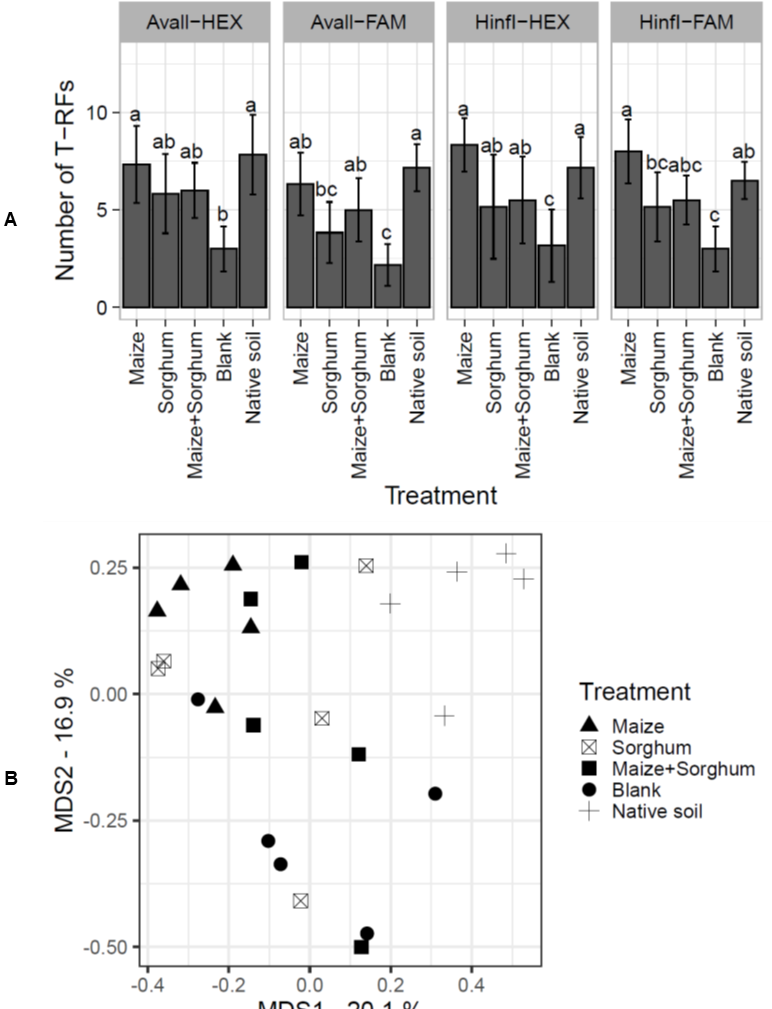
Figure 6. AMF community in trap cultures. 800-bp SSU regions of AMF from various trap cultures, including maize, sorghum, maize + sorghum, blank and native soil, were amplified by the HEX- labelled AML1 primer and FAM-labelled AML2 primer. The terminal restriction fragments (TRFs) in each sample ( n = 6 biological replicates) were derived from the digestion of PCR products by AvaII and HinfI ( A ). Statistical analysis was performed by one-way ANOVA following LSD. Different letters indicate significant differences ( p < 0.05). The multidimensional scaling plot of AMF community compositions ( n = 5 – 6 biological replicates) found in the trap culture soils was generated based on the presence and absence of TRFs from the 5ʹ -HEX-labelled PCR products digested with AvaII and HinfI ( B ).